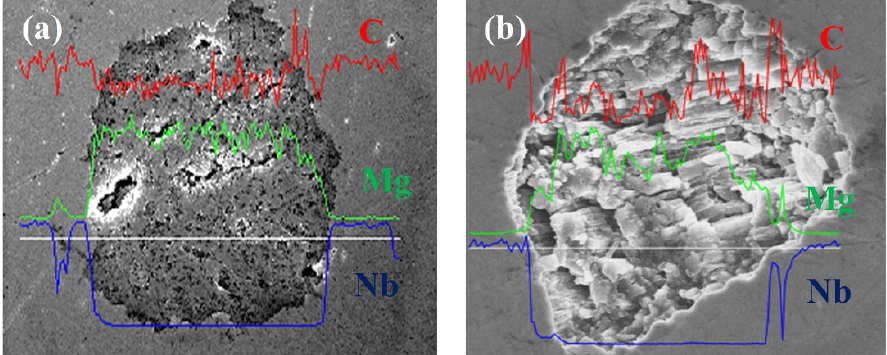
Figure 2. Linear analysis of sample composition for the cross-section ( a ) of sample A—0.1 MPa and ( b ) sample B—1 GPa. The red color means carbon (C), green—magnesium (Mg), dark blue—niobium barrier (Nb).